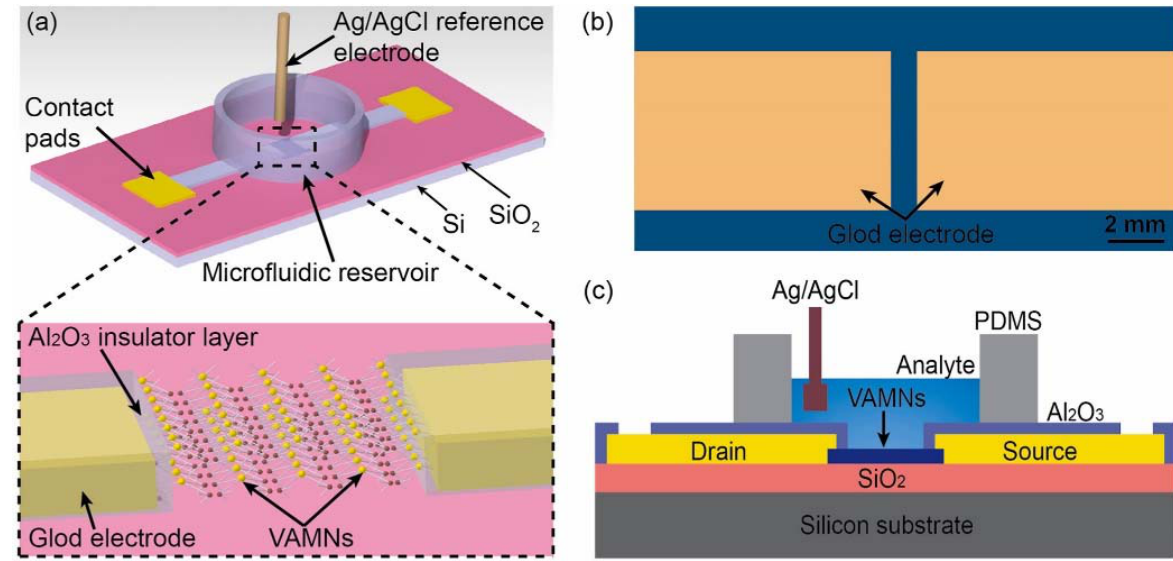
Figure 4. ( a ) Structure formation zoom for design visualization VAMNS = MoS 2 monolayers aligned vertically. ( b ) VAMNS structure. ( c ) Experiment settings. Reprint by permission from Elsevier.